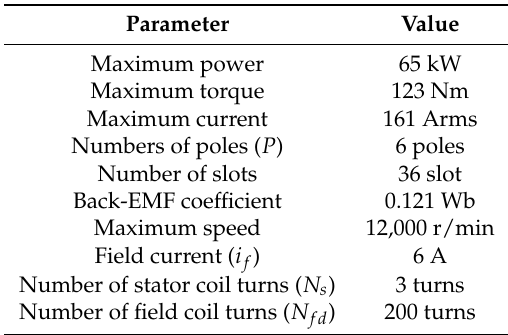
Table 1. Parameters of a WSM used in the